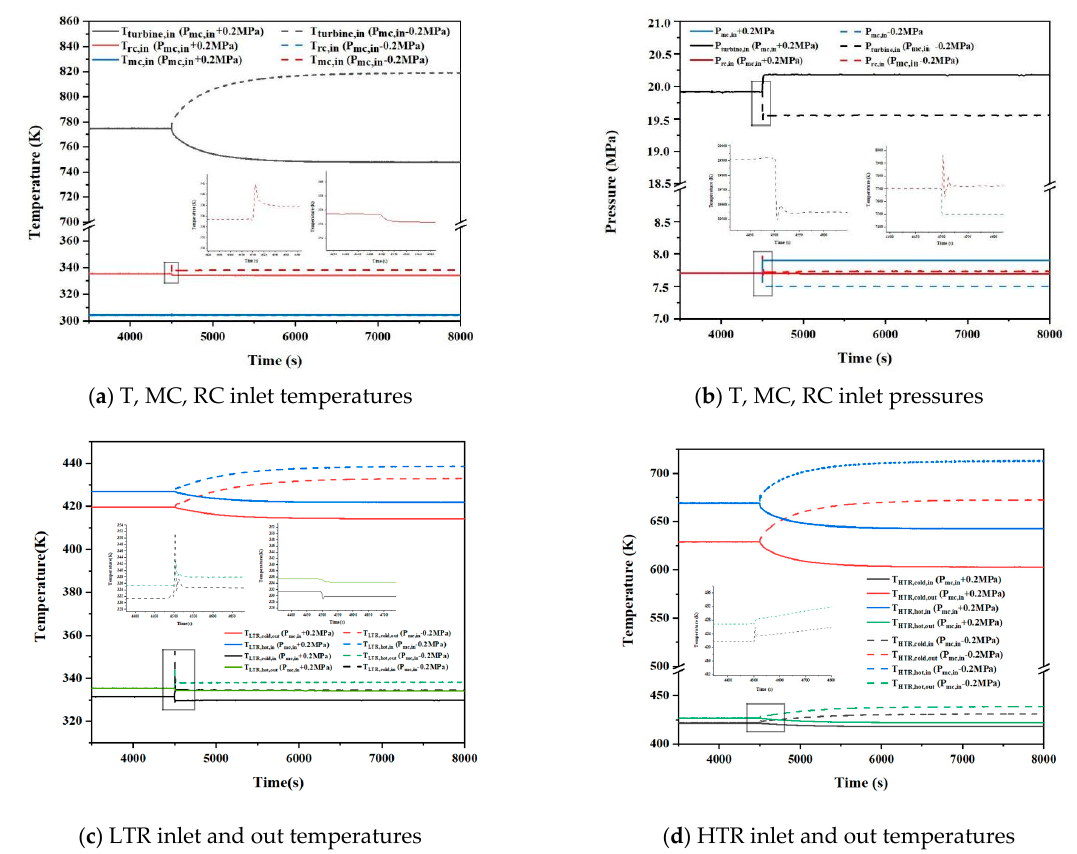
Figure 8. Response curves of main parameters with MC inlet pressure disturbance. When the MC inlet pressure steps up by 0.2 MPa, the MC inlet temperature changes slightly, the RC inlet temperature decreases by about 1.3 K, and the re-stabilization time is about 80 s. The inlet temperature of the turbine is greatly affected by the disturbance of the MC inlet pressure, which is reduced by about 26.2 K, and the re-stabilization time is as long as 2500 s (Figure 8a). Because of the rapid response of pressure, the turbine inlet pressure increases by 0.25 MPa, which shows an approximate step change. Instead, the RC inlet pressure is almost constant (Figure 8b). As the MC inlet pressure increases, the MC outlet temperature decreases, and thus the inlet and outlet temperatures of LTR and HTR decrease. The temperature re-stabilization time of each point on the recuperator cold side increases with the flow direction of low-temperature CO 2 , while the temperature re-stabilization time of each point on the hot side of the recuperators decreases with the flow direction of high-temperature CO 2 (Figure